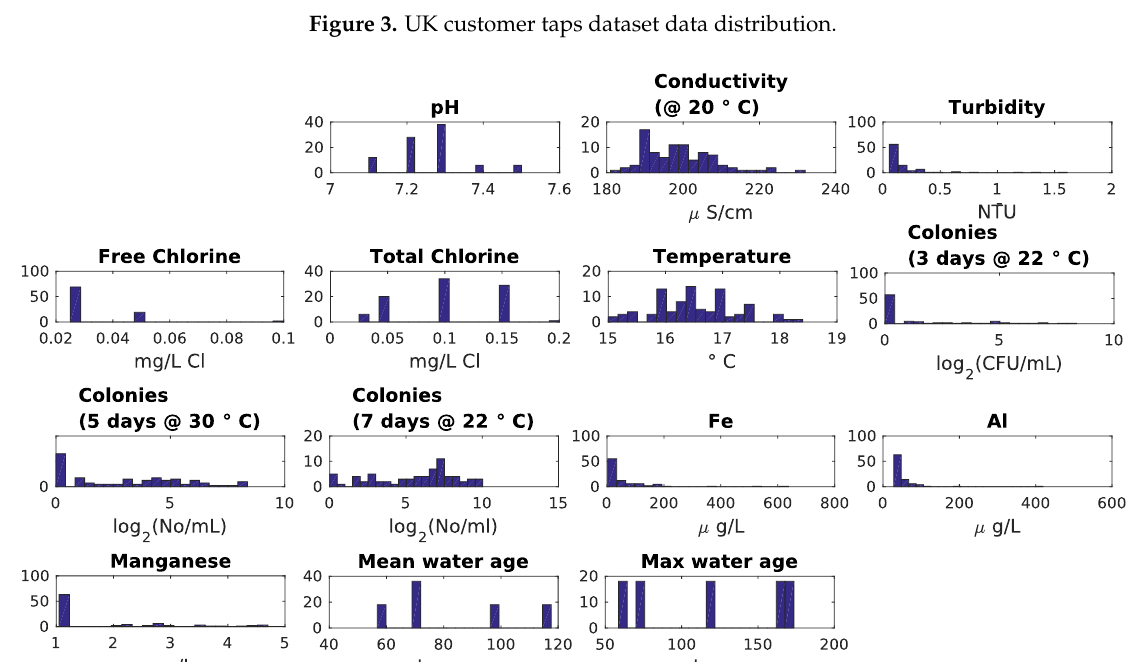
Figure 4. UK small looped network dataset data